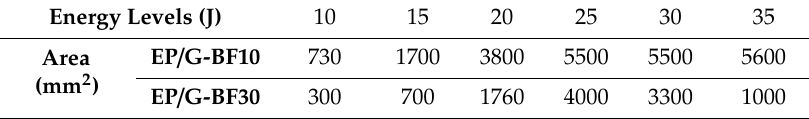
Table 7. Damage area for EP / G-BF10 and EP / G-BF30 at di ff erent energy